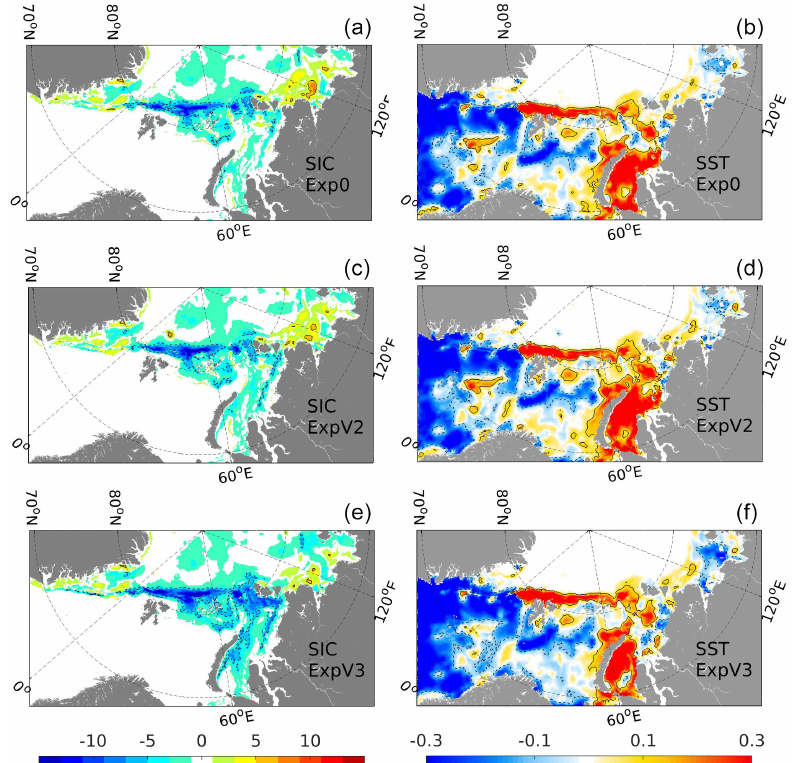
Figure 9. Averaged increments for the 6 month period ( a,b in Exp0; c,d in ExpV2; e,f in ExpV3). The figure shows the European Arctic for clarity. ( a , c and e ) Sea ice concentration (unit: %) with isolines of ± 5%. ( b , d and f ) SST with isolines of ± 0.1 ◦